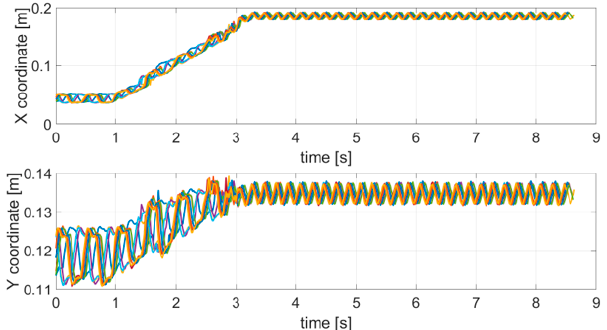
Figure 6. Acquired trajectories (x and y coordinates) for each SM test carried out.